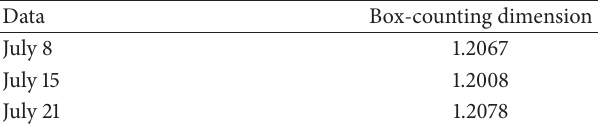
Table 1: Box-counting dimension.